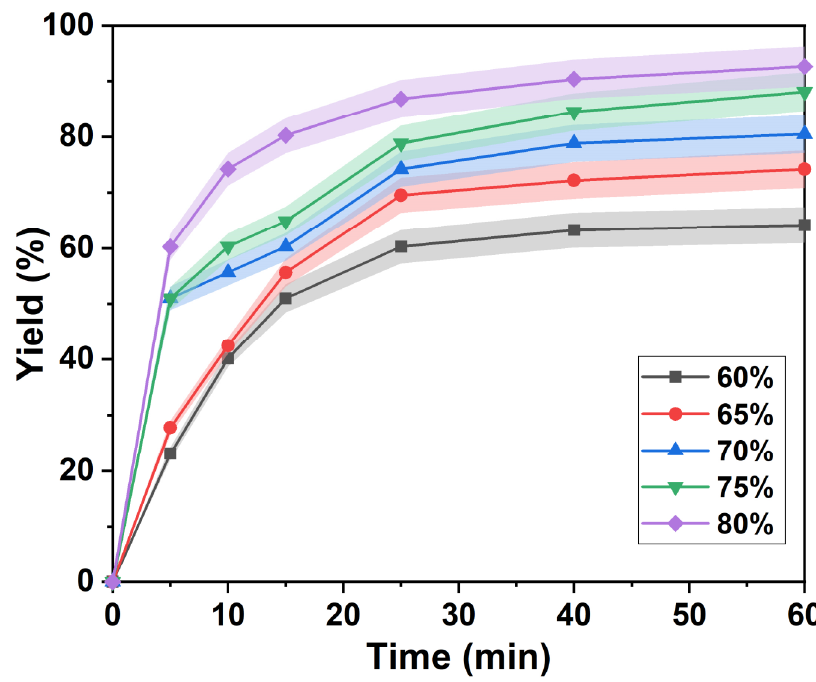
Figure 1. Lignin separation yield in the presence of different p -TsOH concentrations.